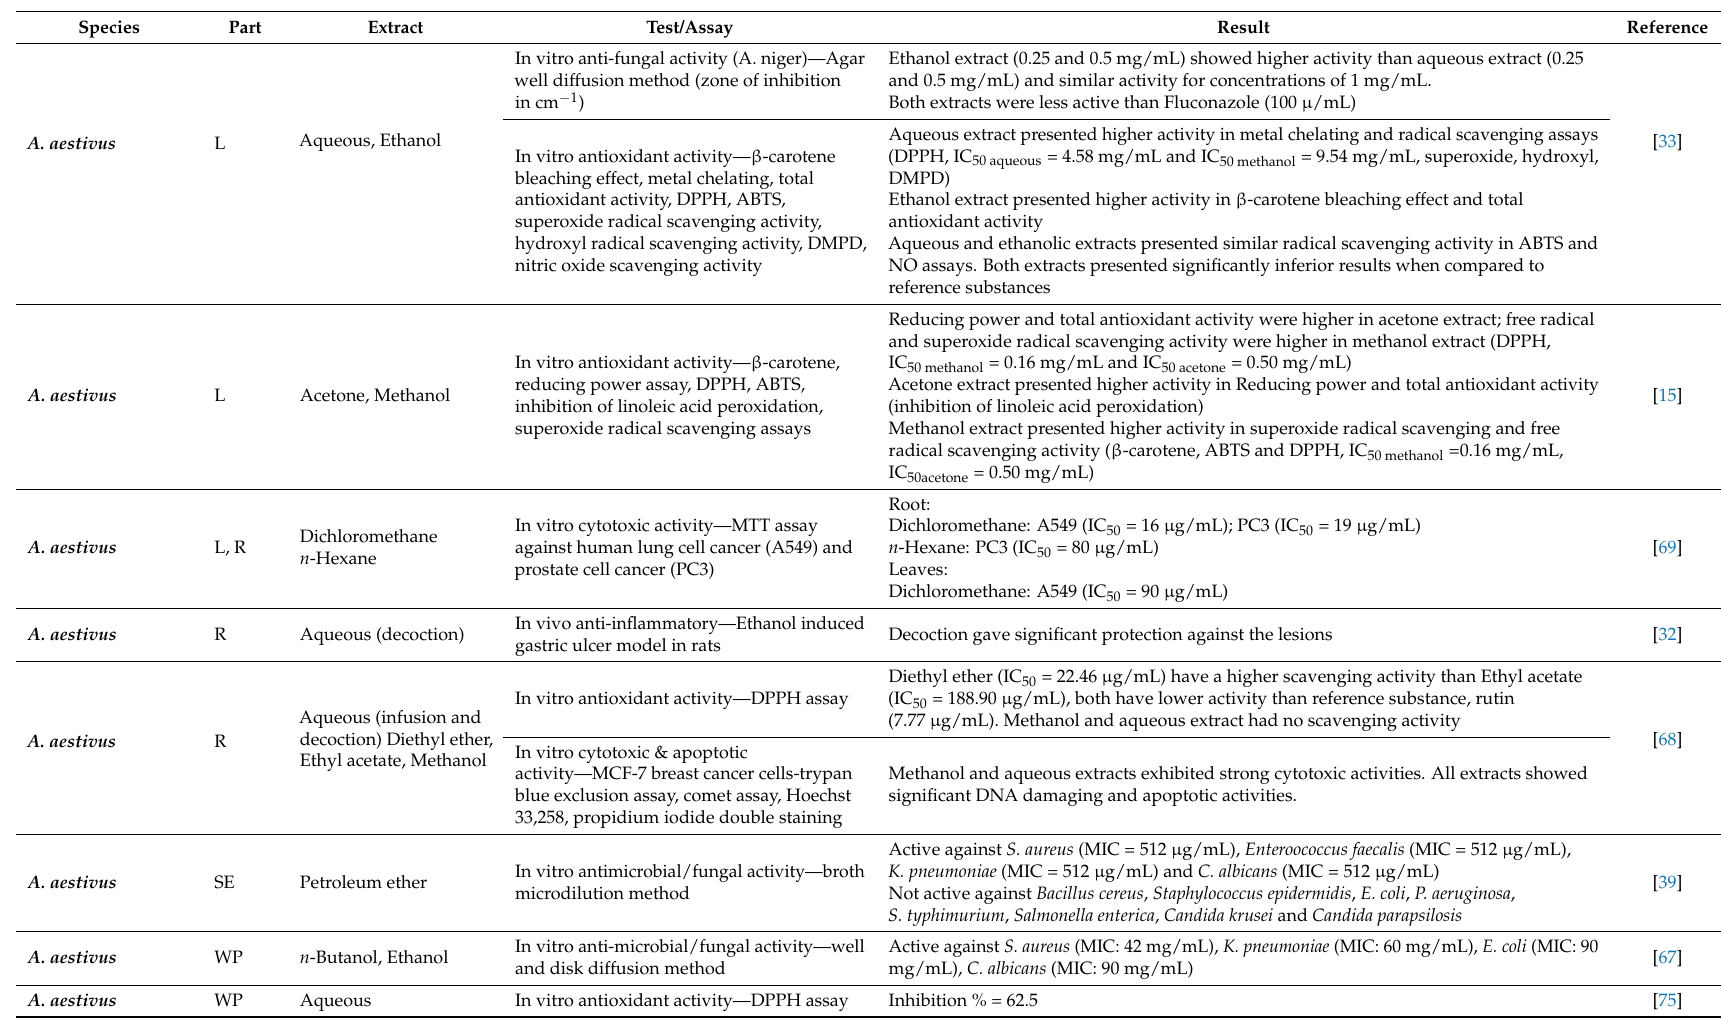
Table 3. In vitro and in vivo biological studies reported from the Asphodelus